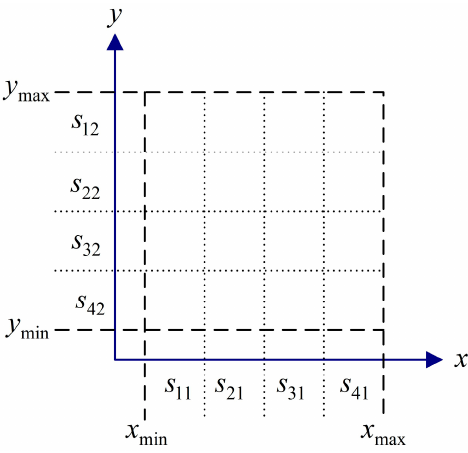
Figure 2. Situational knowledge.